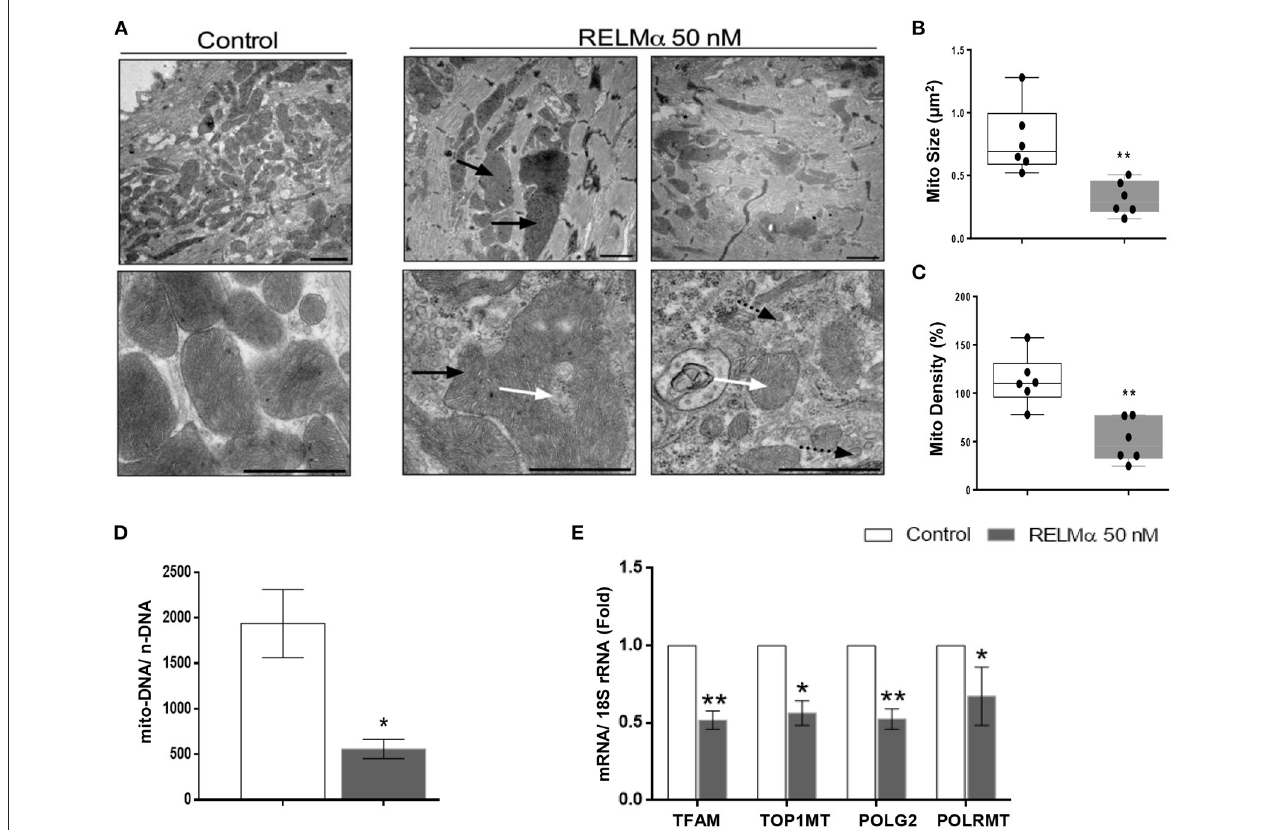
FIGURE 5 | RELM α impairs mitochondrial ultrastructure, biogenesis and its replication machinery in NRCMs. (A) Representative electron micrographs taken from NRCMs stimulated with or without recombinant RELM α . Low magnification images (upper) were used to evaluate mitochondrial density, and high magnification images (lower) were used to investigate the ultrastructure of mitochondria. Arrows indicate structurally abnormal mitochondria (black arrow: giant mitochondria, white arrow: abnormal cristae structure, black arrow with dotted tail: small, fragmented mitochondria). Scale bars are 1 µ m. (B) Representative electron micrographs showing mitochondrial morphology quantitated as average mitochondrial size ( µ m 2 ), and (C) mitochondrial density per microscopic field by using imageJ software. (D) Estimation of mitochondrial DNA copy number (mito-DNA/nuclear DNA ratio) by quantitative PCR in NRCMs. (E) Quantitative PCR analyses of